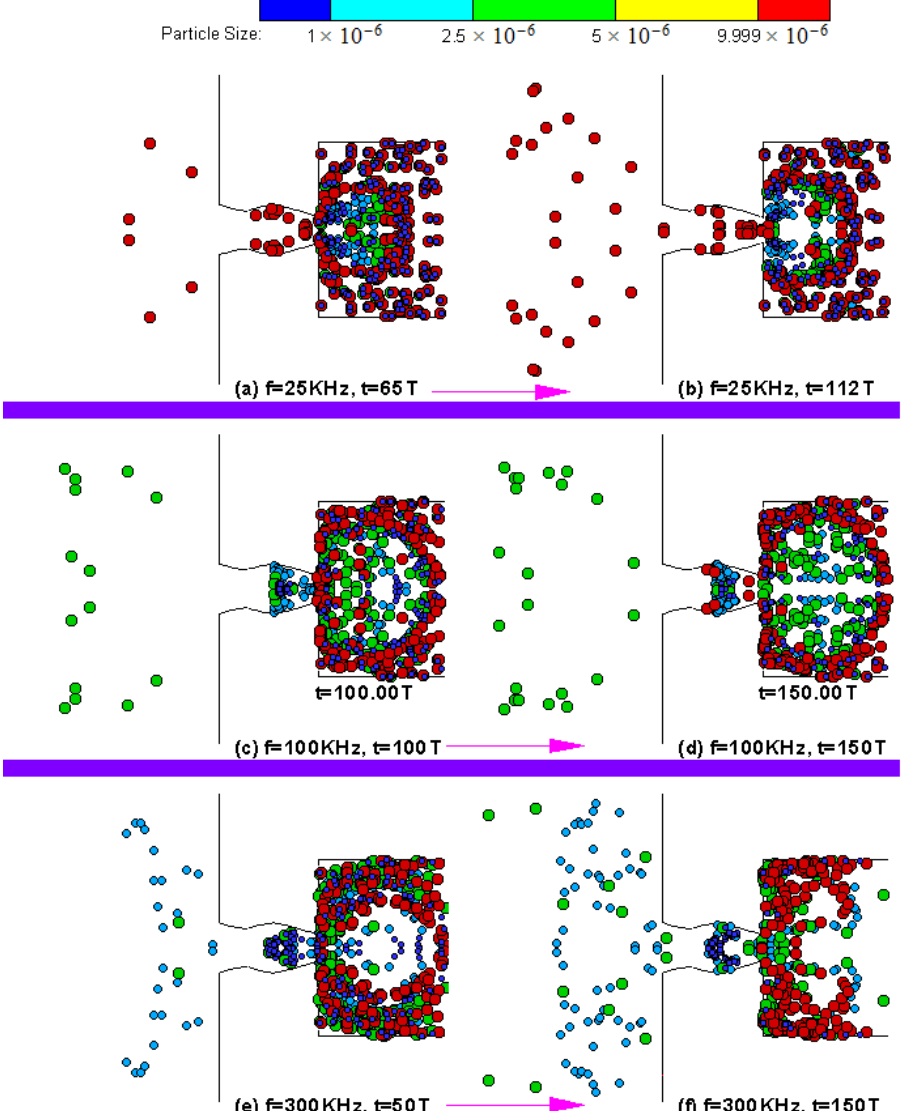
Figure 7. Design simulations of a particle separator device. ( a ) f = 25 KHz, t = 65 T; ( b ) f = 25 KHz, t = 112 T; ( c ) f = 100 KHz, t = 100 T; ( d ) f = 100 KHz, t = 150 T; ( e ) f = 300 KHz, t = 50 T; ( f ) f = 300 KHz, t = 150 T. Reproduced from reference [21], with the permission of ASME Publishing.